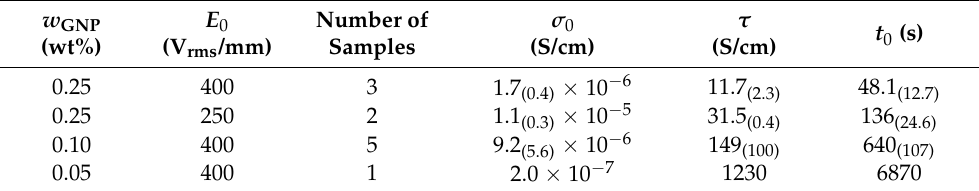
Table 1. Fitting results of logistic growth model, Equation (5), describing conductivity growth in EVA/GNP composites at 160 ◦ C (numbers in parentheses represent the standard deviation across different